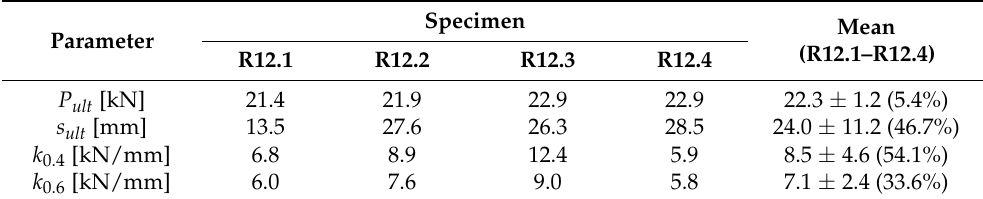
Table 10. The results of the push-out tests of the shear connections with 12 mm screws and without toothed-plate connectors (per one connector).